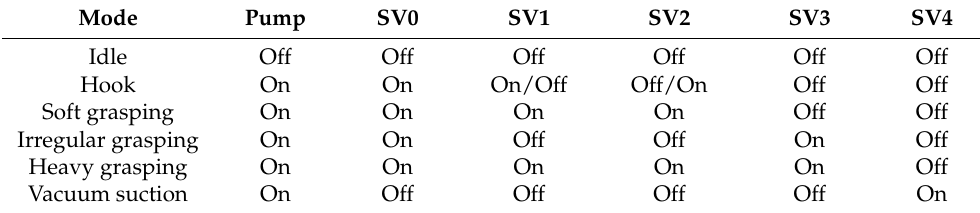
Figure 10. Schematic diagram of ( a ) the pneumatic and ( b ) the electric system of the automatic equipment. Table 1. Switching combinations of the diaphragm pump and the solenoid valves for different working modes of the modular gripper.